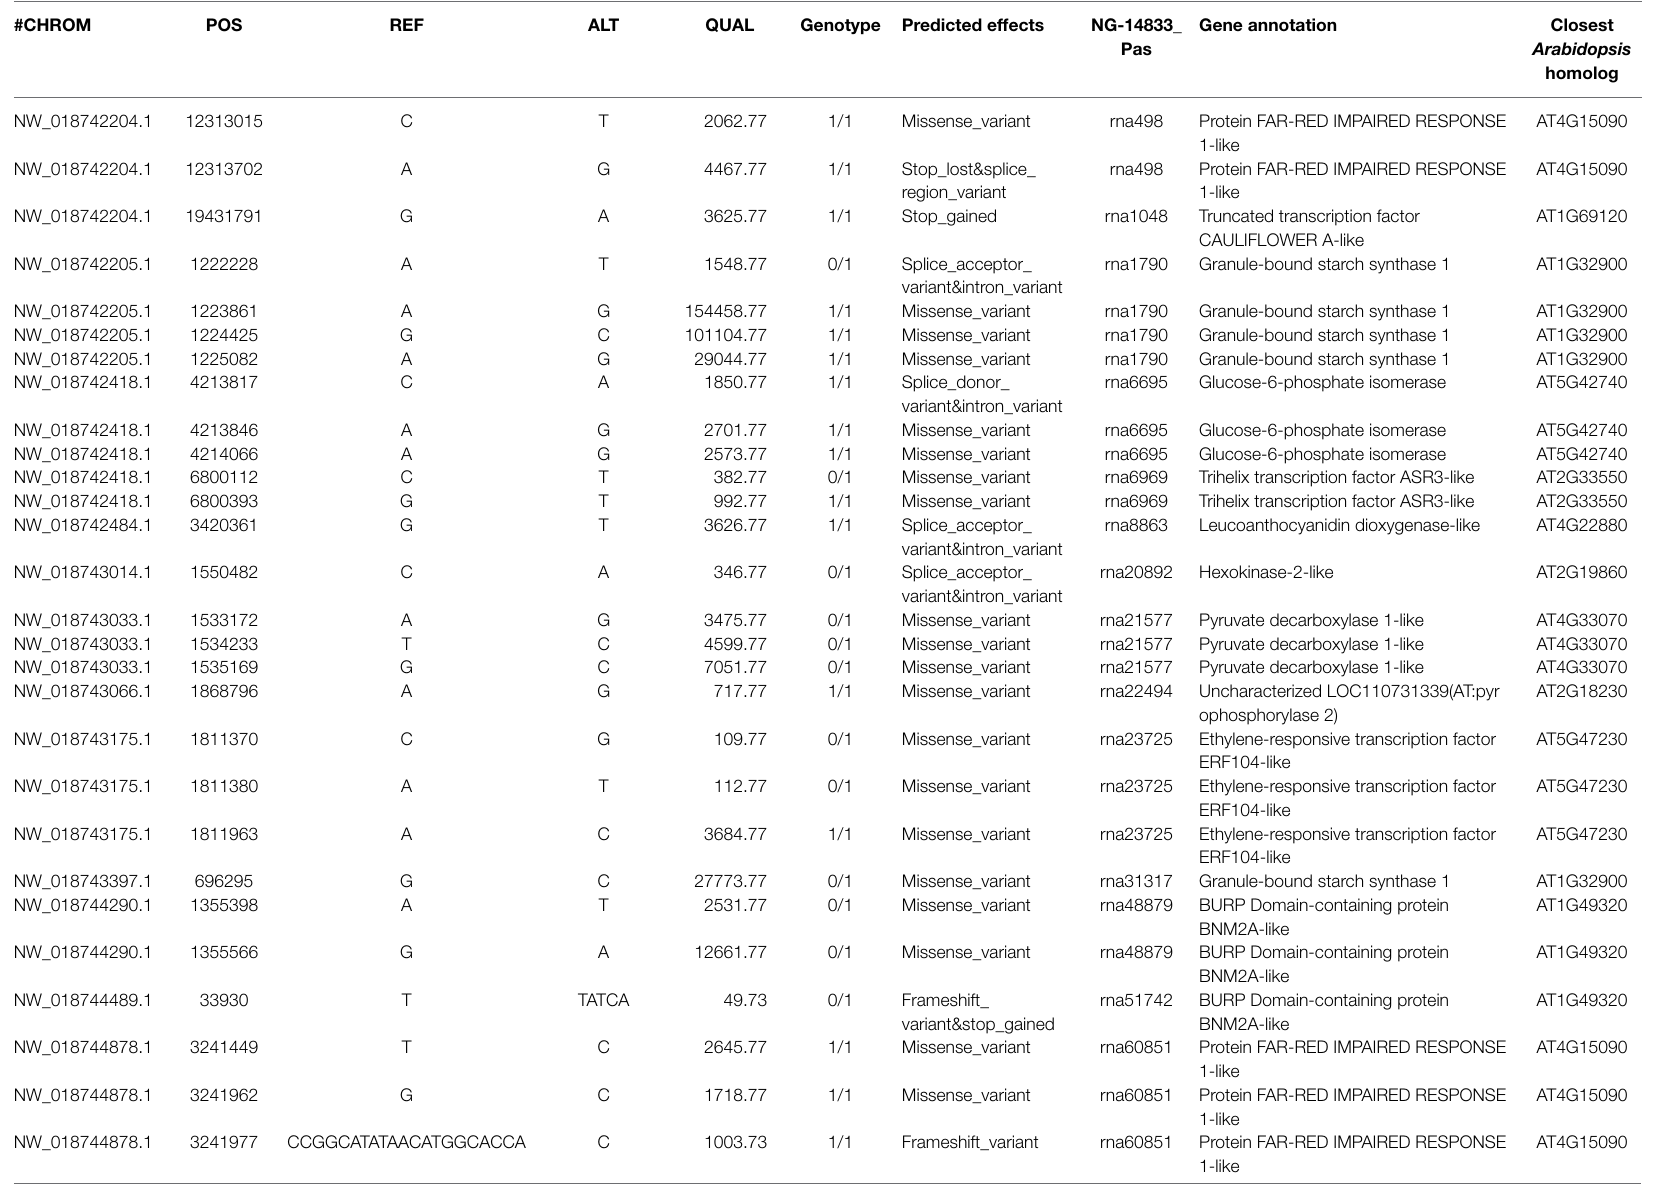
TABLE 3 | List of moderate to high impact SNPs/InDels found in Pasankalla seed transcripts as compared to the reference genome in 19 of the 60 candidate transcripts (listed in Supplementary Table S5